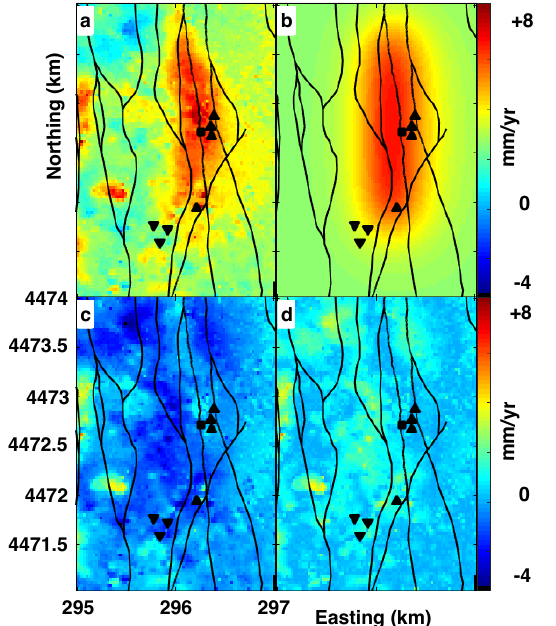
Figure 4. Deformation fields in terms of (unwrapped) range change rate from the SqueeSAR ENVI T27 stack spanning 23rd June 2004 to 28th April 2010 analyzed using nonlinear inversion methods outlined in Feigl and Thurber [30]. Inversion was performed using unwrapped range change rates. Results are shown in terms of unwrapped range change rate: observed range change rate ( a ), modeled range change rate ( b ), residual between observed and modeled ( c ) and absolute value of residuals ( d ). Faults are denoted with black lines. Inverted triangles are injection wells and upright triangles are production wells. The power plant is denoted with a black square. Coordinates are easting and northing kilometers in the UTM projection zone 11N, WGS84 [15].